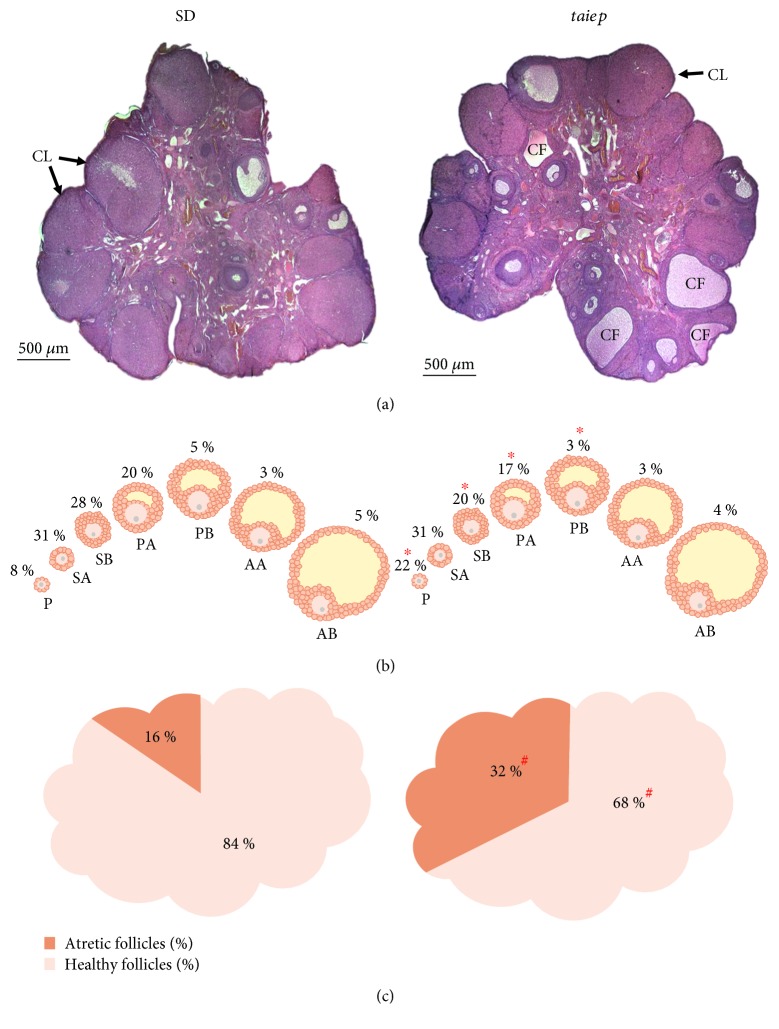
Follicle population in Sprague–Dawley and taiep rats in the adult stage. (a) Representative histological slice of the ovary. (b) Percentages of follicles in the different categories. (c) Percentages of atretic and healthy follicles in the ovary. SD: Sprague–Dawley; CF: cystic follicle; CL: corpora lutea; P: primary; SA: secondary A; SB: secondary B; PA: preantral A; PB: preantral B; AA: antral A; AB: antral B. ∗p ≤ 0.01z-test and #p ≤ 0.001z-test.